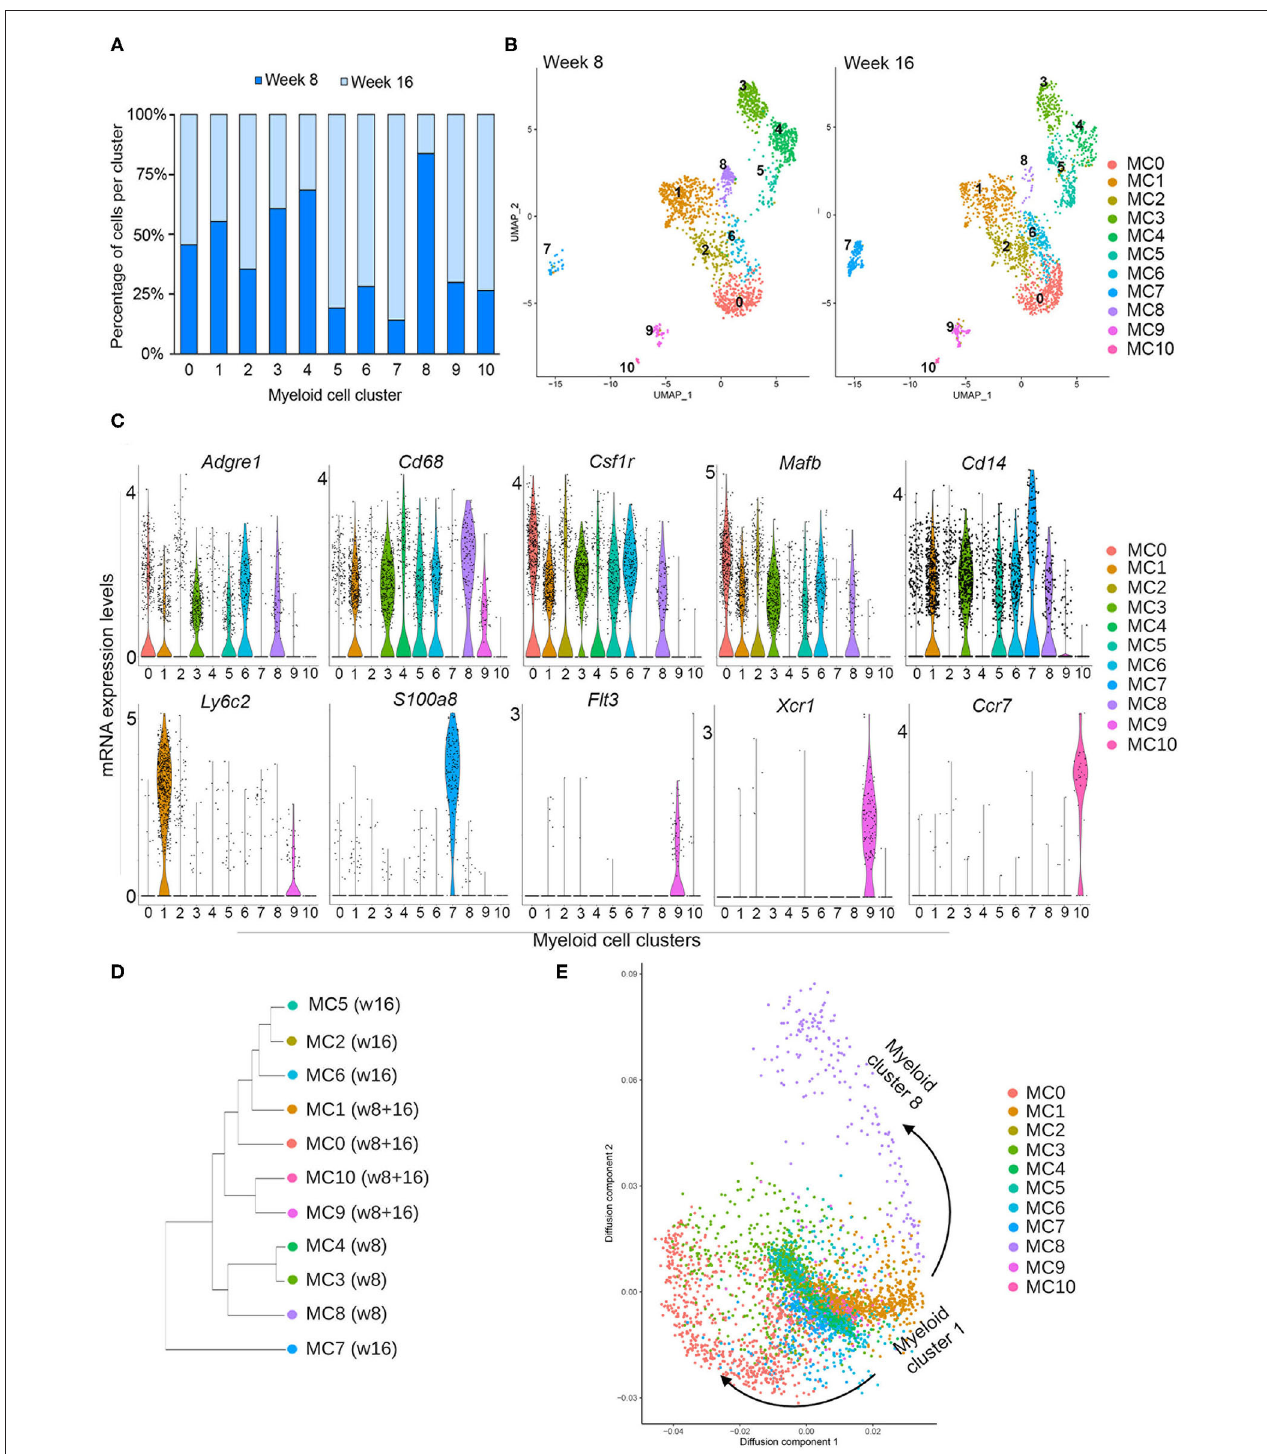
FIGURE 2 | Myeloid subclusters based on CD14 expression. (A) Graph depicts the number of cells in each myeloid cell cluster as a percentage at week 8 (dark blue) and week 16 (light blue). (B) UMAPs depict the distribution of CD14 + myeloid cells at week 8 (left) or week 16 (right), identifying 11 distinct myeloid clusters (MC 0–10) and their abundance at each timepoint. (C) Violin plots demonstrate the distribution of various genes in each myeloid cluster that are commonly expressed in macrophages ( Adgre1, Cd68, Csfr1, Mafb, Cd14 ), monocytes ( Ly6c2 ), other myeloid cells ( S100a8 ), and dendritic cells ( Flt3, Xcr1, Ccr7 ). (D) Dendrogram shows similarities among subclusters and enrichment for each cluster at week 8 or week 16. (E) Diffusion map for myeloid subclusters demonstrating a branch point at cluster 1, which represents Ly6c2 + monocytes.